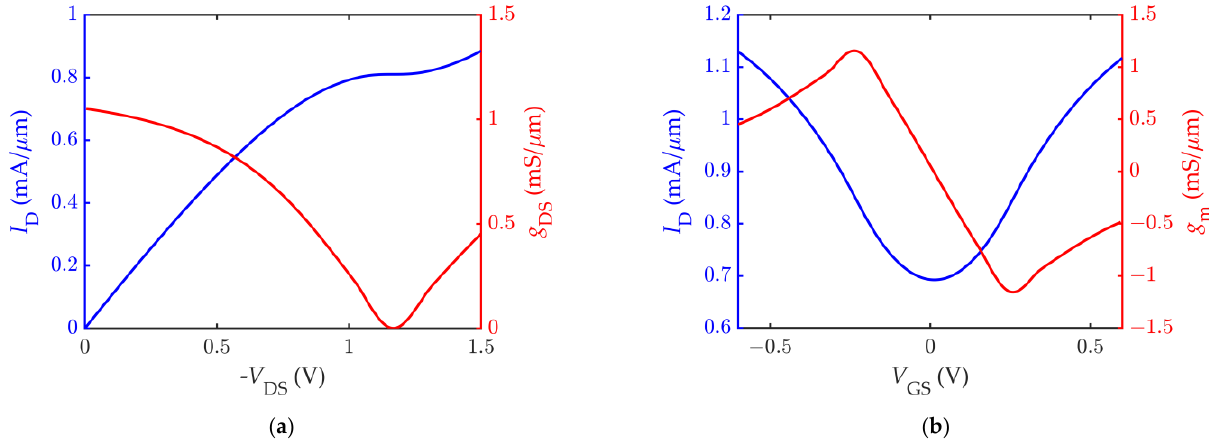
Figure 3. The DC characteristic of the simulated GFET: ( a ) the drain current I D (in blue) against the drain-source voltage at V GS = −0.2 V, with superimposed output conductance g ds (in red); ( b ) the drain current I D (in blue) against the gate-source voltage at V DS = −1.2 V, with superimposed transconductance g m (in red).